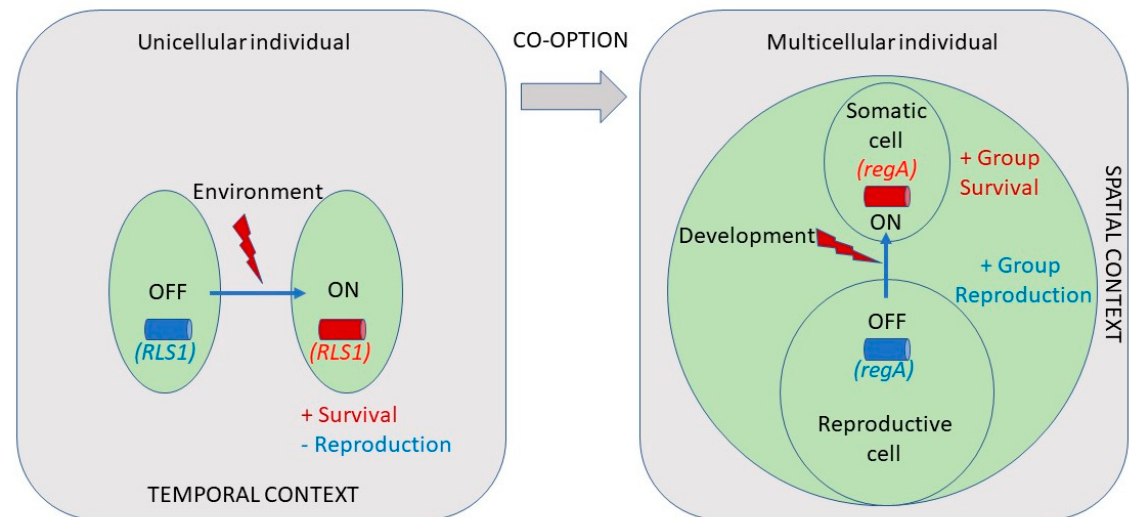
Figure 8. Co-option of a life history gene (e.g., RLS1 ) that traded off reproduction for survival in a single-celled ancestor into a regulator of soma/germ cell differentiation (e.g., regA ) in a multicellular descendant by changing its expression from a temporal context (in response to an environmental cue) into a spatial context (in response to a developmental cue). The co-opted gene is inactive in reproductive germ cells but becomes active in somatic cells during development. Adapted from the study by Nedelcu and Michod [17].